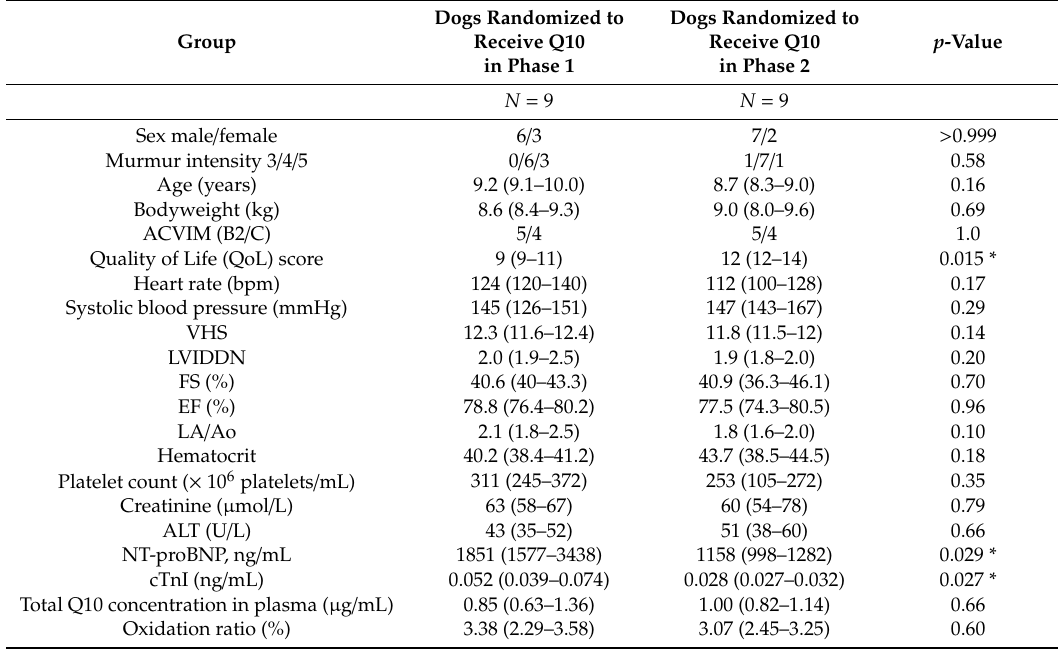
Table 1. Baseline demographics and clinical characteristics of the 18 Cavalier King Charles Spaniels included in the statistical analyses. Dogs were either randomized to receive Q10 first, then placebo (Q10 in phase 1) or to receive placebo first, then Q10 (Q10 in phase 2). Dogs Randomized to Group Receive